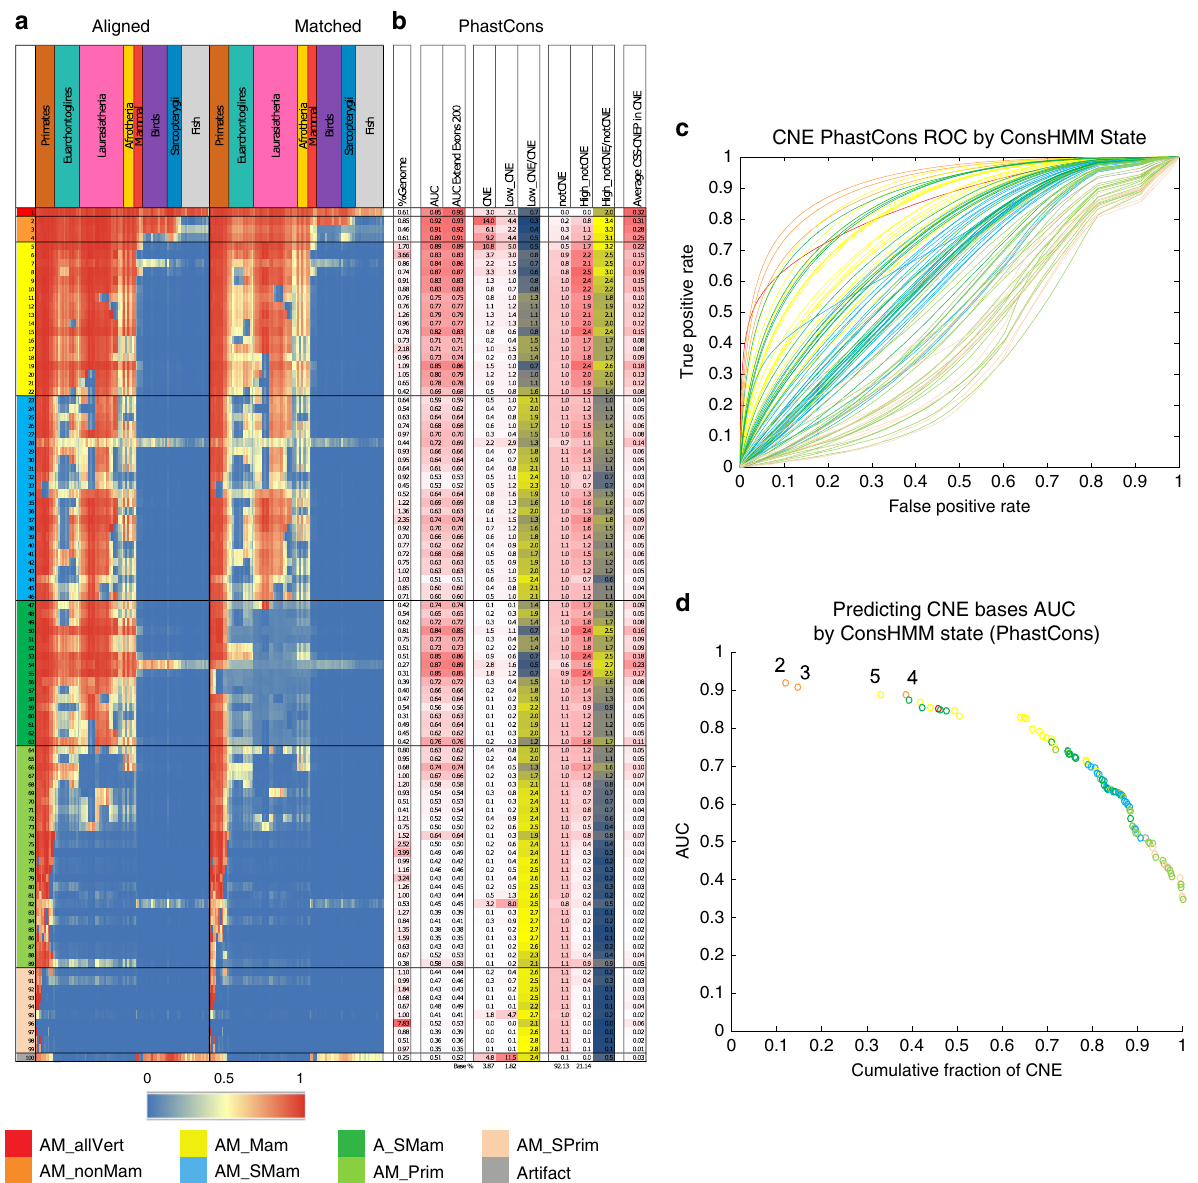
Fig. 6 CNE prediction depends on conservation state. a Heatmap for the ConsHMM conservation state model from ref. 32 . Rows correspond to conservation states that were previously clustered into eight groups labeled at bottom and colored accordingly (Fig. 1b). For each state, the left and right halves indicate the probability of the species of the column having a nucleotide aligning to and matching to the human reference genome, respectively. Major groups of species are colored and labeled. b The fi rst column reports the genome percent of each state. The second column contains the AUC of the CNEP score for predicting CNE bases in each state (see “ Methods ” section), where for this and the remaining columns the constrained elements are from PhastCons. The next column reports the AUC when exons are fi rst extended by 200 bp. The next three columns contain the fold enrichment for CNE bases, Low_CNE bases, and the ratio of the Low_CNE to CNE enrichments. The following three columns contain the fold enrichment for notCNE bases, High_notCNE bases, and the ratio of the High_notCNE to notCNE enrichments. The last column shows the average CSS-CNEP score in CNE bases in the state. Adjacent pairs of columns with a red-white color scale are on the same color scale, while other columns are on a column speci fi c color scale. The bottom row gives the genome coverage percent of the column. Results based on all the constrained element sets is in Supplementary Fig. 22. c ROC curves for the CNEP score identifying PhastCons CNE bases in speci fi c ConsHMM conservation states colored based on the coloring in a . d Plot showing the AUC values for each ROC curve shown in c with the same coloring. The AUC values are displayed from left to right based on decreasing values and positioned along the x -axis based on the cumulative fraction of PhastCons CNE bases that they cover. States with the highest AUC values are labeled. Similar plots, but for additional constrained element and based on excluding bases within 200 bp of exons from the positives are in Supplementary Figs. 23 and 24. Source data are provided as a Source Data fi